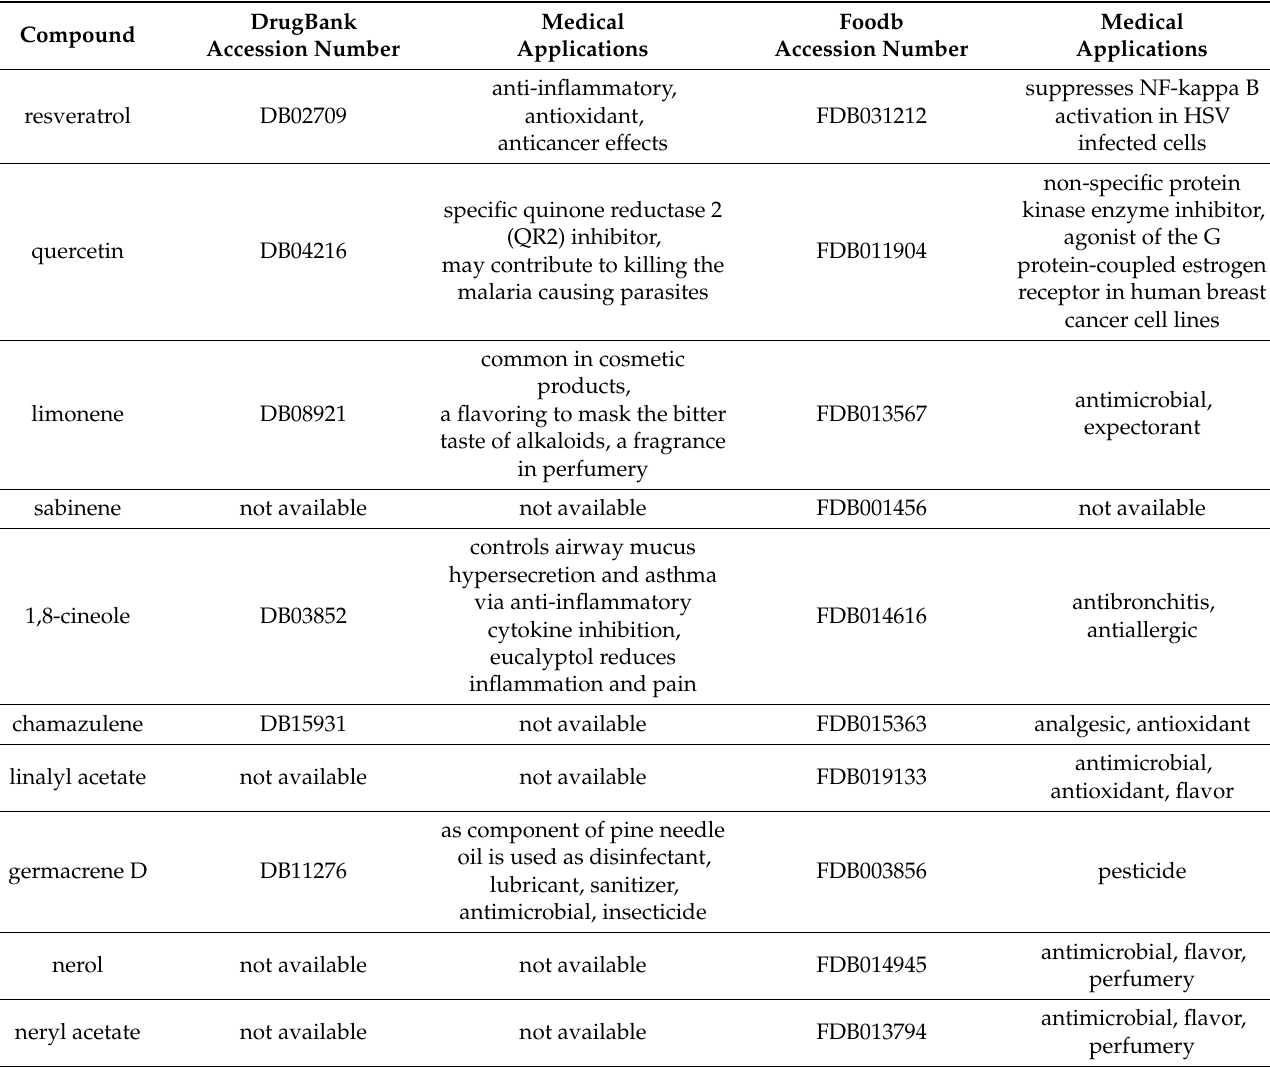
Table 1. Applications of the natural compounds indexed in the critical data bases DrugBank 5.1.8 [31] and Foodb